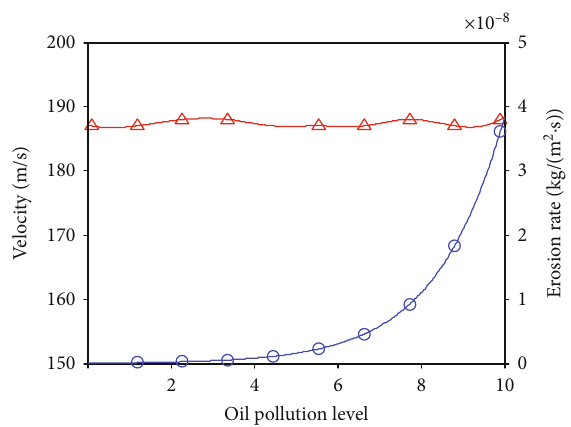
Figure 17: The relation curves among oil velocity, erosion rate, and oil pollution